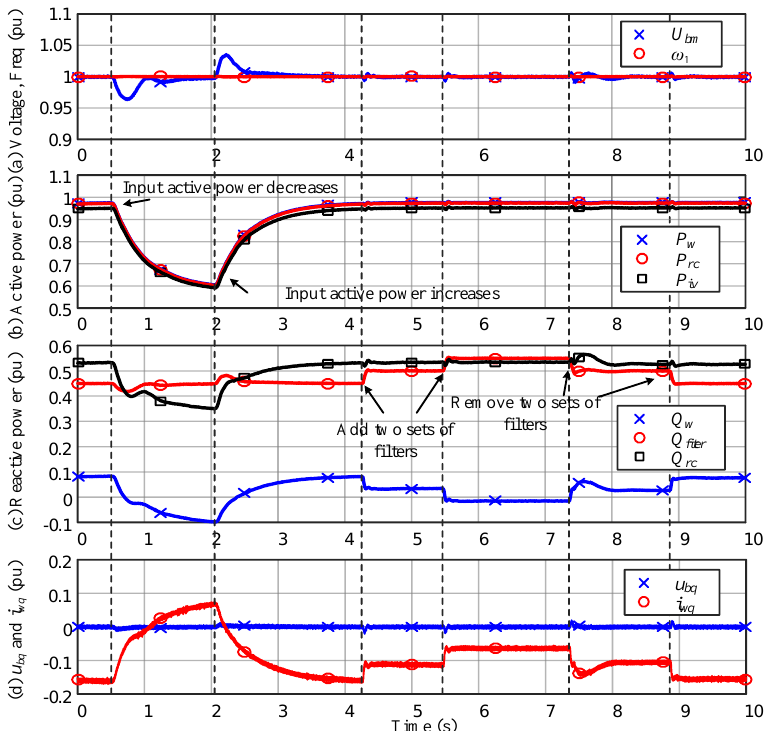
Figure 16. Simulation results under external disturbances, where the WF is represented by a single WECS with the PI-type Q - f control. ( a ) Sending-end bus voltage and frequency; ( b ) active power; ( c ) reactive power; ( d ) dq -axis sending-end bus voltage.